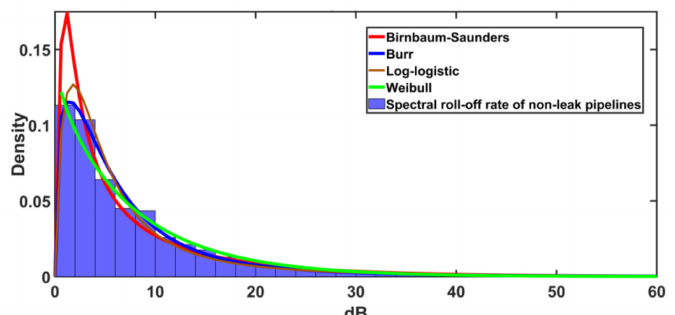
Figure 11. Comparison of the distributions fitting the spectral roll-off rates of the acoustic emission signals of pipelines without a leakage.